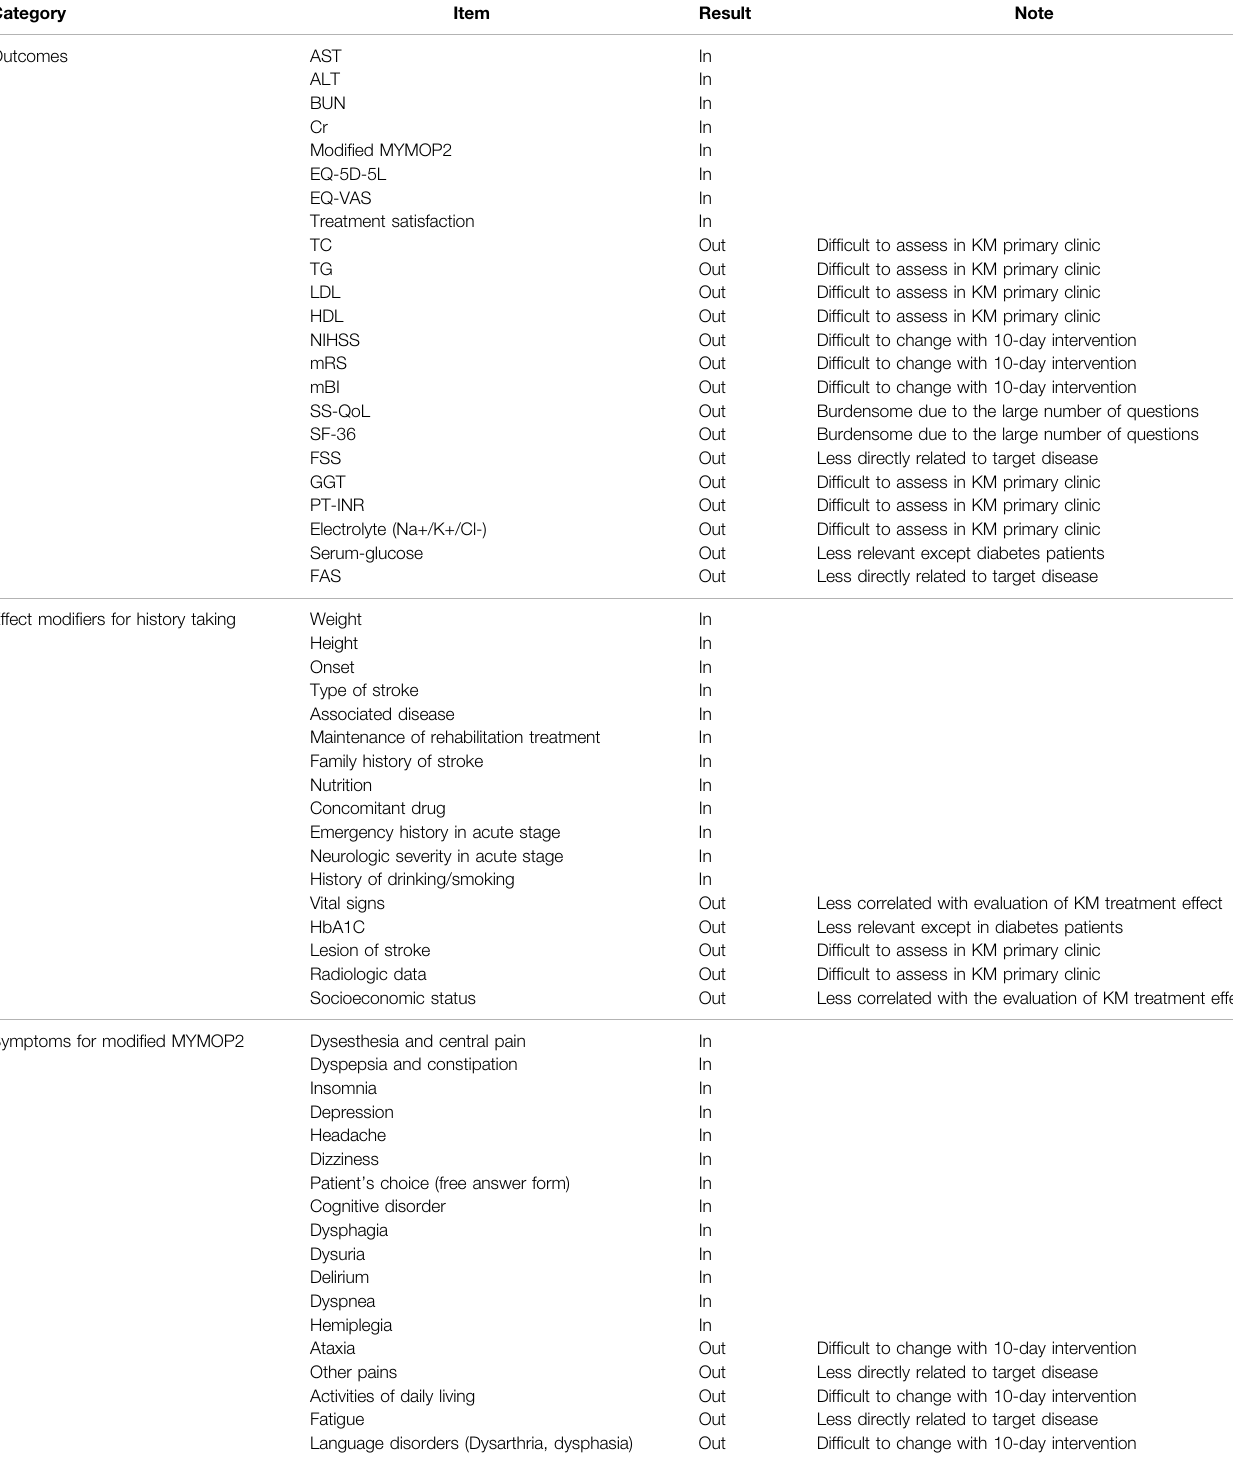
TABLE 2 | Summary of the consensus process during the three Delphi questionnaires.